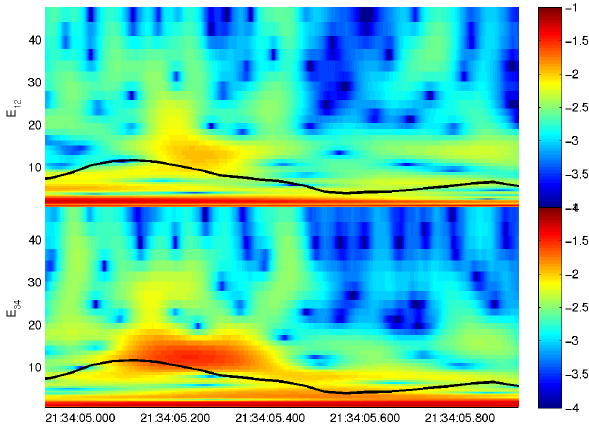
Fig. 3. The wavelet dynamic spectrogram of electric fields E 12 (top) and E 34 showing a the occurrence of oscillations just above the lower-hybrid resonance frequency (black line) for event 1.